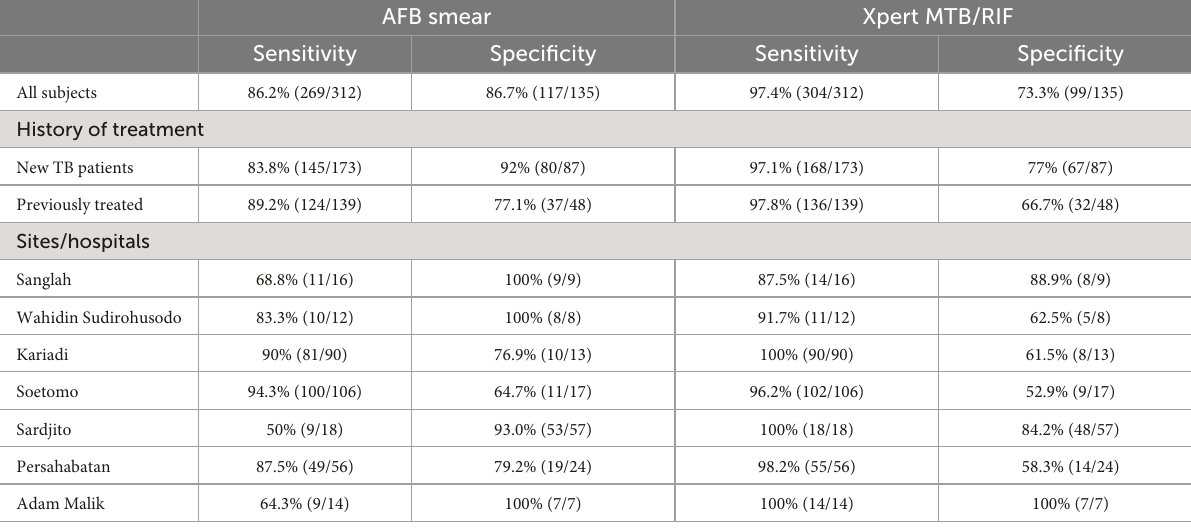
TABLE 2 Diagnosis of tuberculosis by AFB smear and Xpert MTB/RIF compared to sputum culture as the gold standard. AFB smear Xpert MTB/RIF